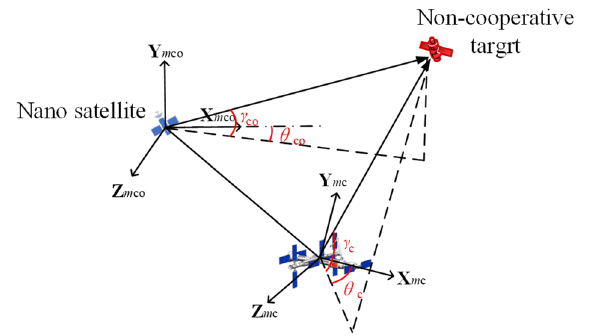
Figure 3. The geometric relationship of the dual-view